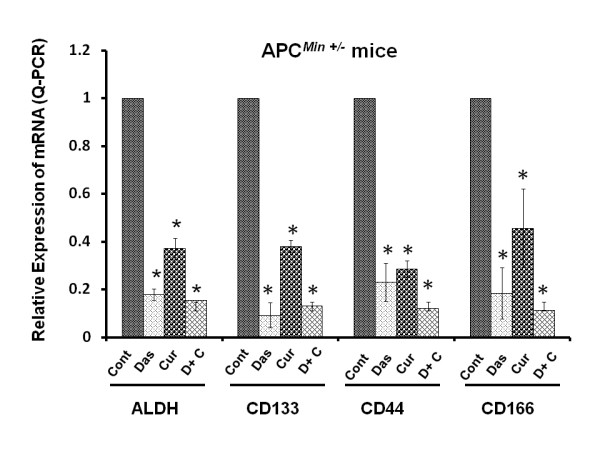
Relative expression of various cancer stem cell markers in tumor remnants from APCMin +/- mice treated with dasatinib and/or curcumin as determined by RT-PCR. Tissue was procured from our previous study where Female Min mice (5 weeks; female C57BL/6J- APCMin +/- ) were treated with dasatinib (10 mg/kg body weight) and/or curcumin (250 mg/kg body weight). The treatment was given for five consecutive days per week for 4 weeks. At the end of respective treatments, the mice were euthanized and tumor remnants were obtained as described previously [30]. RNA isolated from the tissue was analyzed for expression of different CSCs specific markers.